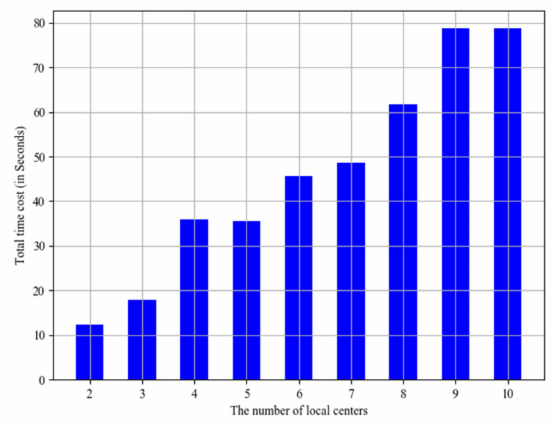
Figure 13. Total time costs with di ff erent local center number.